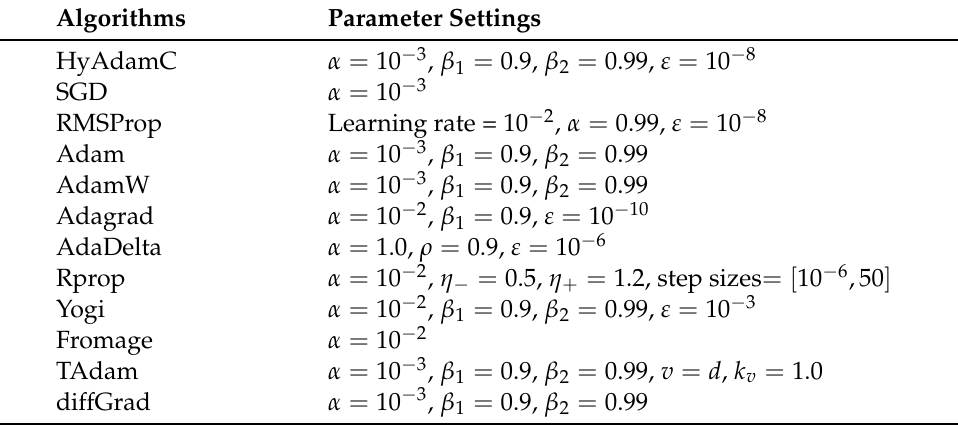
Table 1. The parameter settings of HyAdamC and the compared first-order optimization